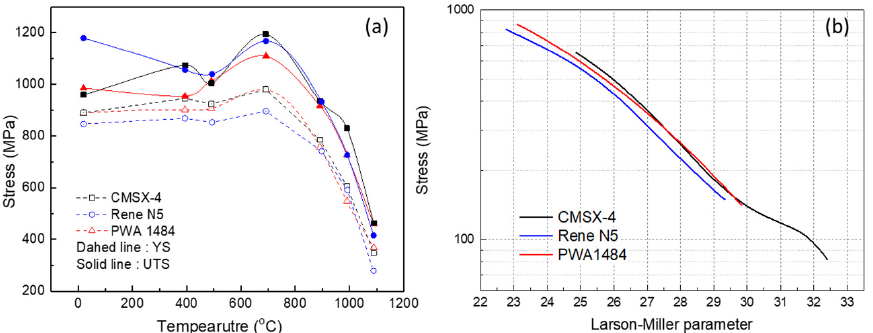
Figure 4. Mechanical properties of second-generation single crystal superalloys, ( a ) strength, ( b ) Larson-Miller plot [3,19].